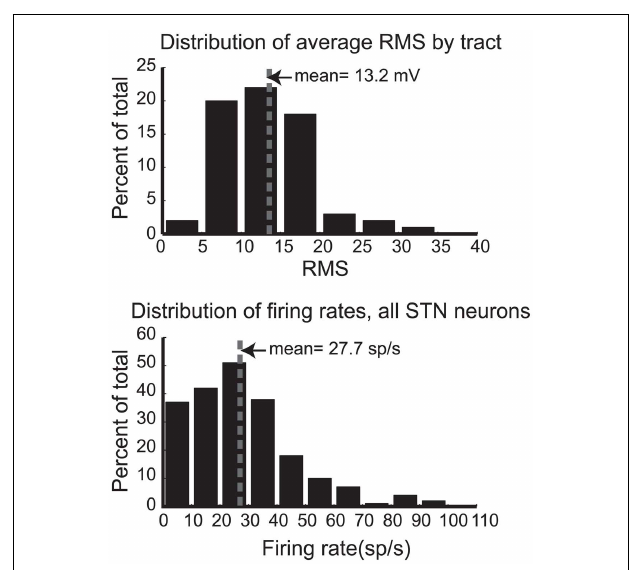
FIGURE 4 | Distributions of root mean square power (RMS, upper panel) for each STN pass and firing rates (lower panel) for all STN neurons . Mean values are indicated by the dotted